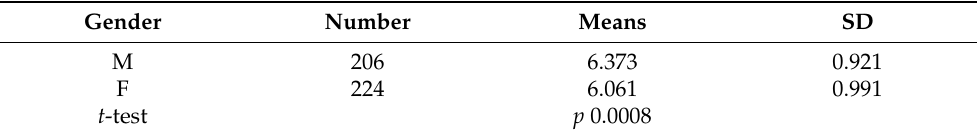
Table 5. Average values and standard deviation for the Corsi’s test score in NORM, with respect to gender.